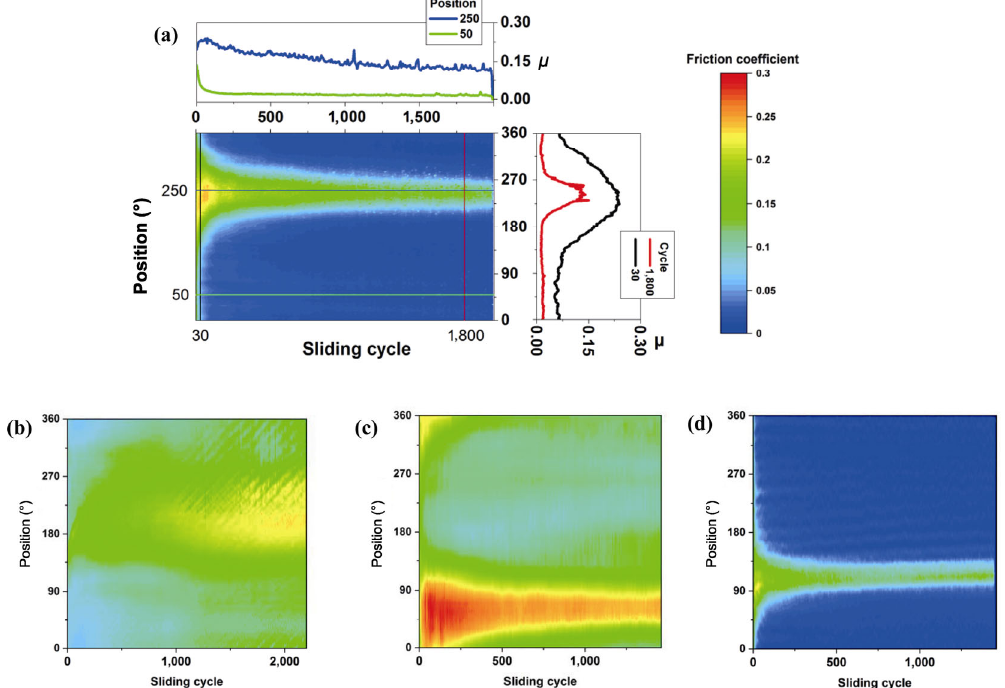
Fig. 12 Friction map of wear track on SiC disk with sliding: (a) In NDP–COOH (0.1 wt%) and 50 mm/s); top and right curves represent friction evolutions in two wear positions (247° and 50°) and two sliding cycles (30 th and 1,800 th ), respectively; (b) in water and P = 500 mW; (c) in NDP–COOH (0.1 wt%) and in (d) in NDP–COOH (0.1 wt%) and P = 1,500 mW (15 N and 100 mm/s). Rainbow scale bar describes intensity of friction in coefficients and applies to all four